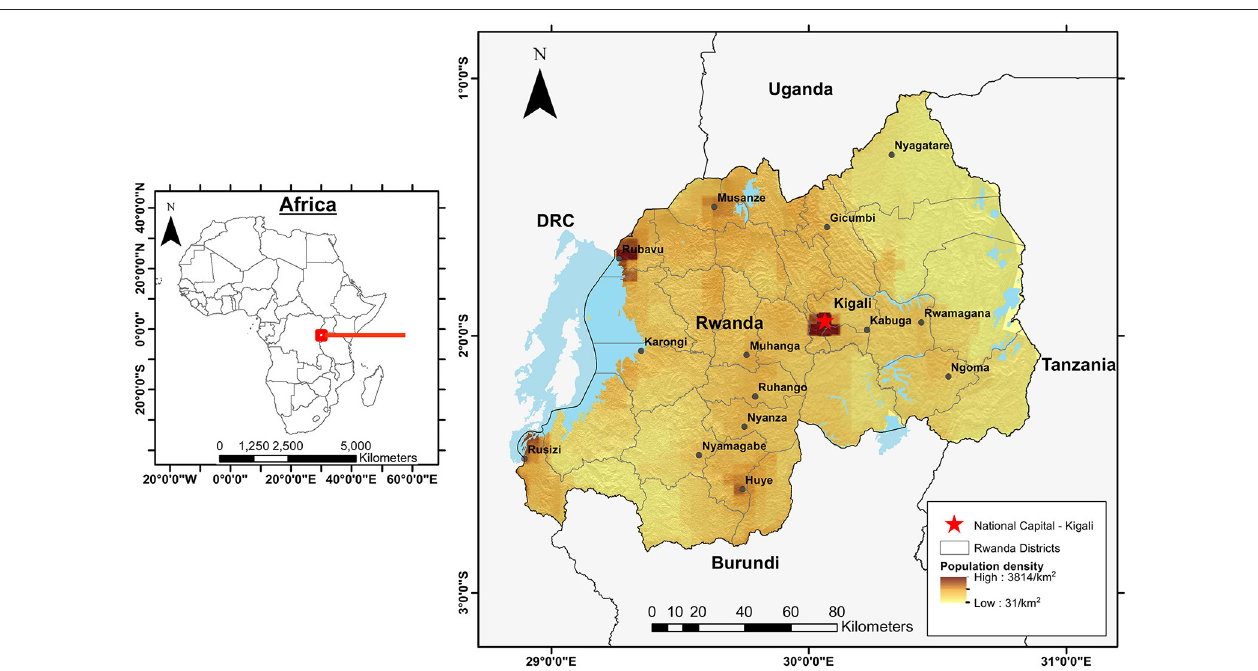
FIGURE 1 | Map of Rwanda. Rwandan districts and population density included for